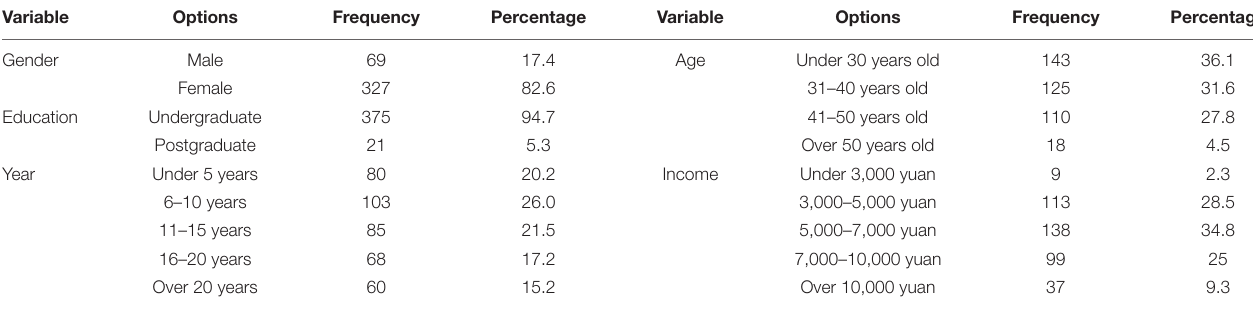
TABLE 1 | Frequency and percentage of the